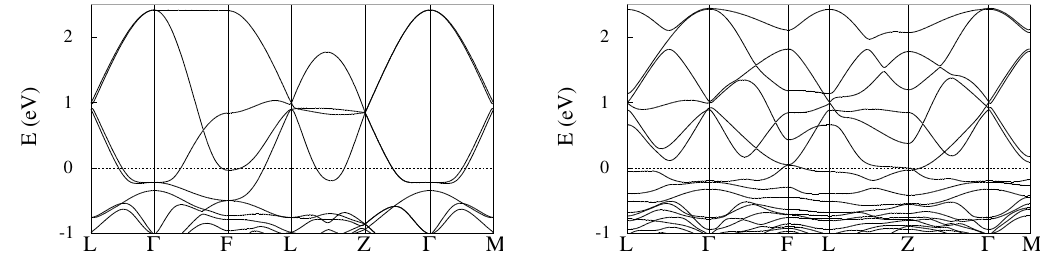
Figure 4: Calculated band structures of the nonmagnetic R 3 c LaNiO the disproportionated antiferromagnetic R -type LaNiO agation wave vector ( 0,0, 1 → Γ ( 0,0,0 ) → F ( 1 L ( 1 ,0,0 ) r 2